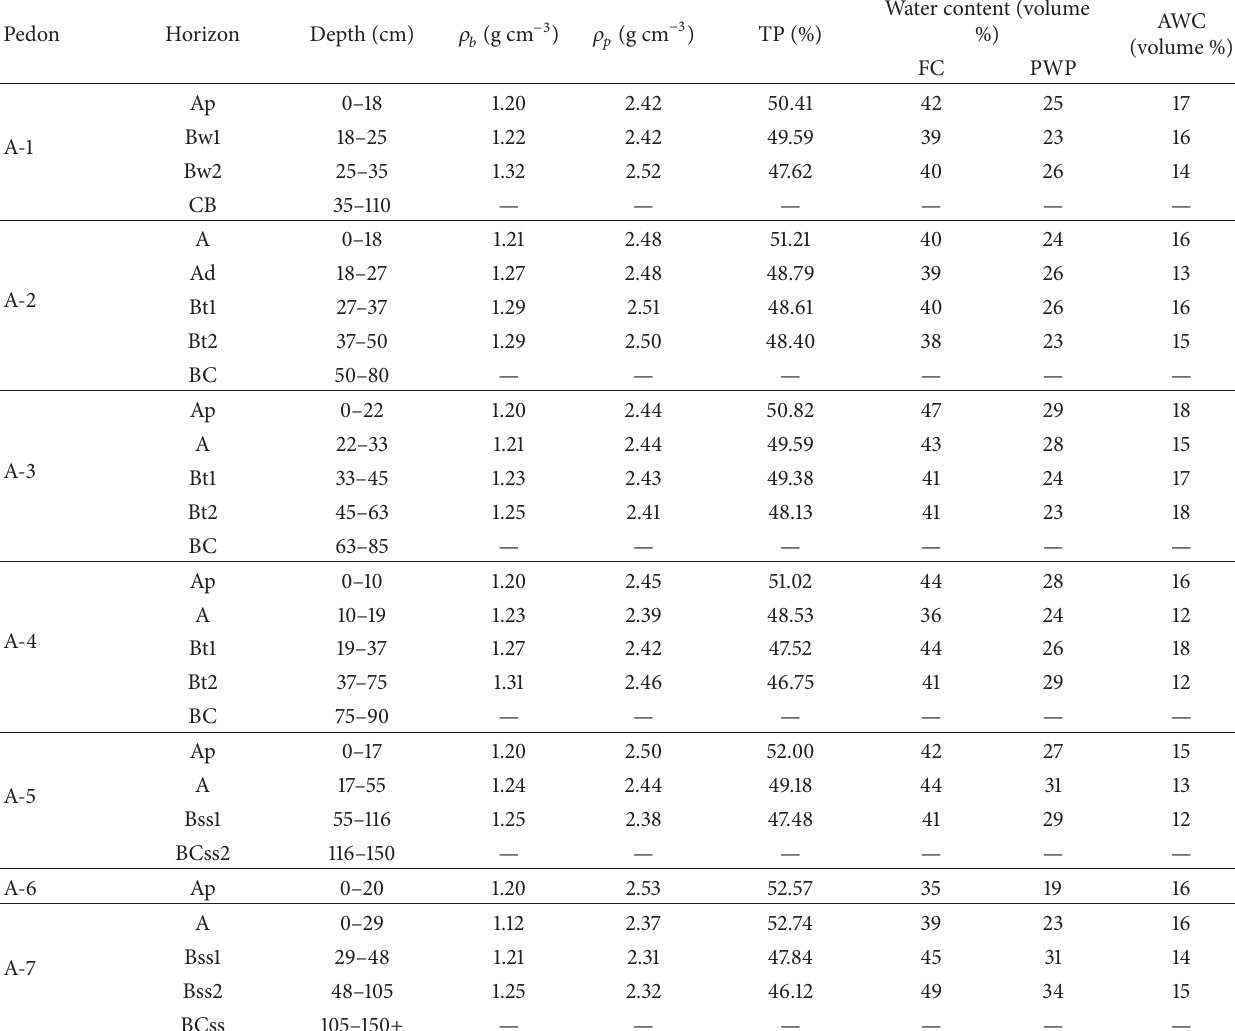
Table 4: Bulk density ( 𝜌 𝑏 ), particle density ( 𝜌 𝑝 ), total porosity (TP), water content, and available water content (AWC) of soils of Abobo area. Pedon